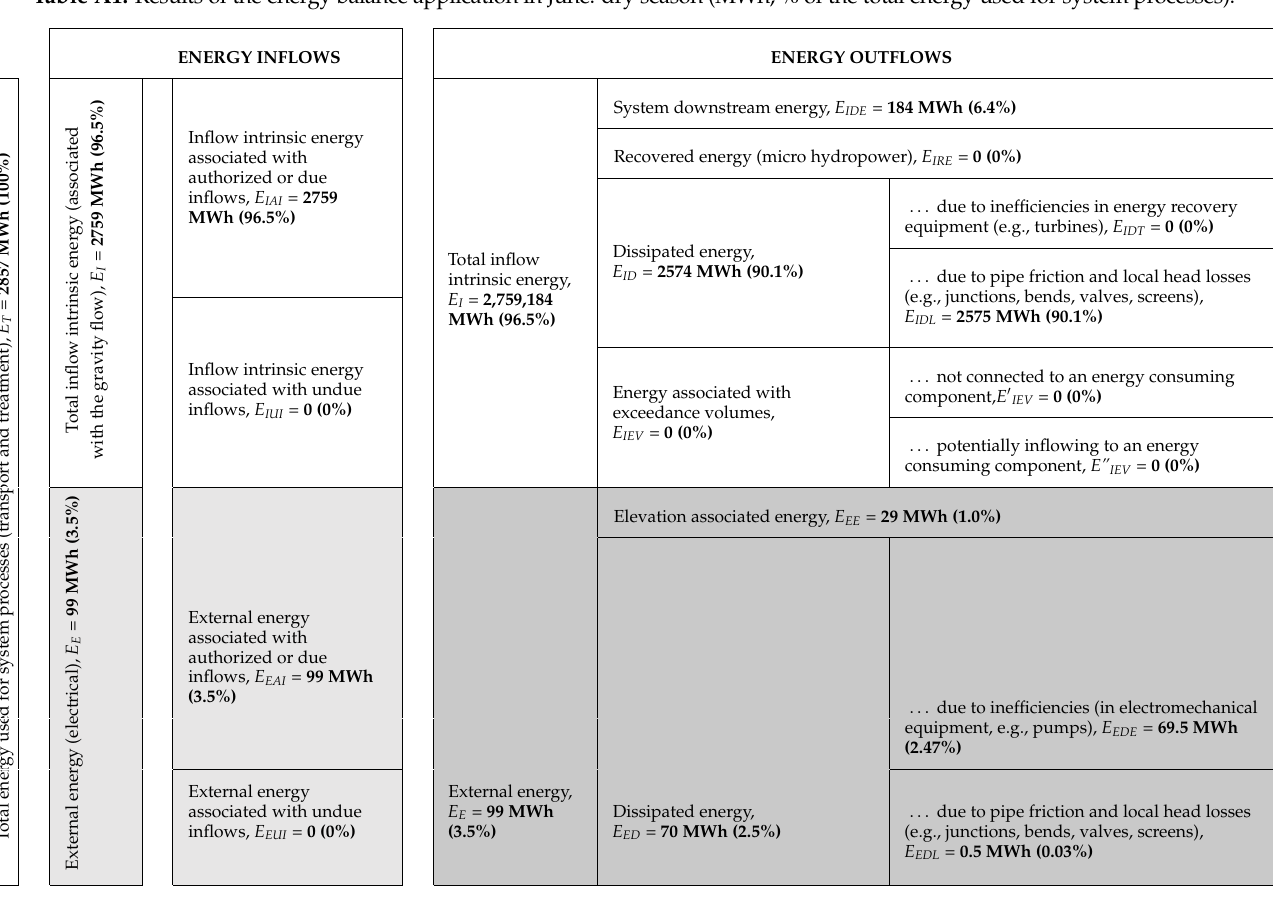
Table A1. Results of the energy balance application in June: dry season (MWh, % of the total energy used for system